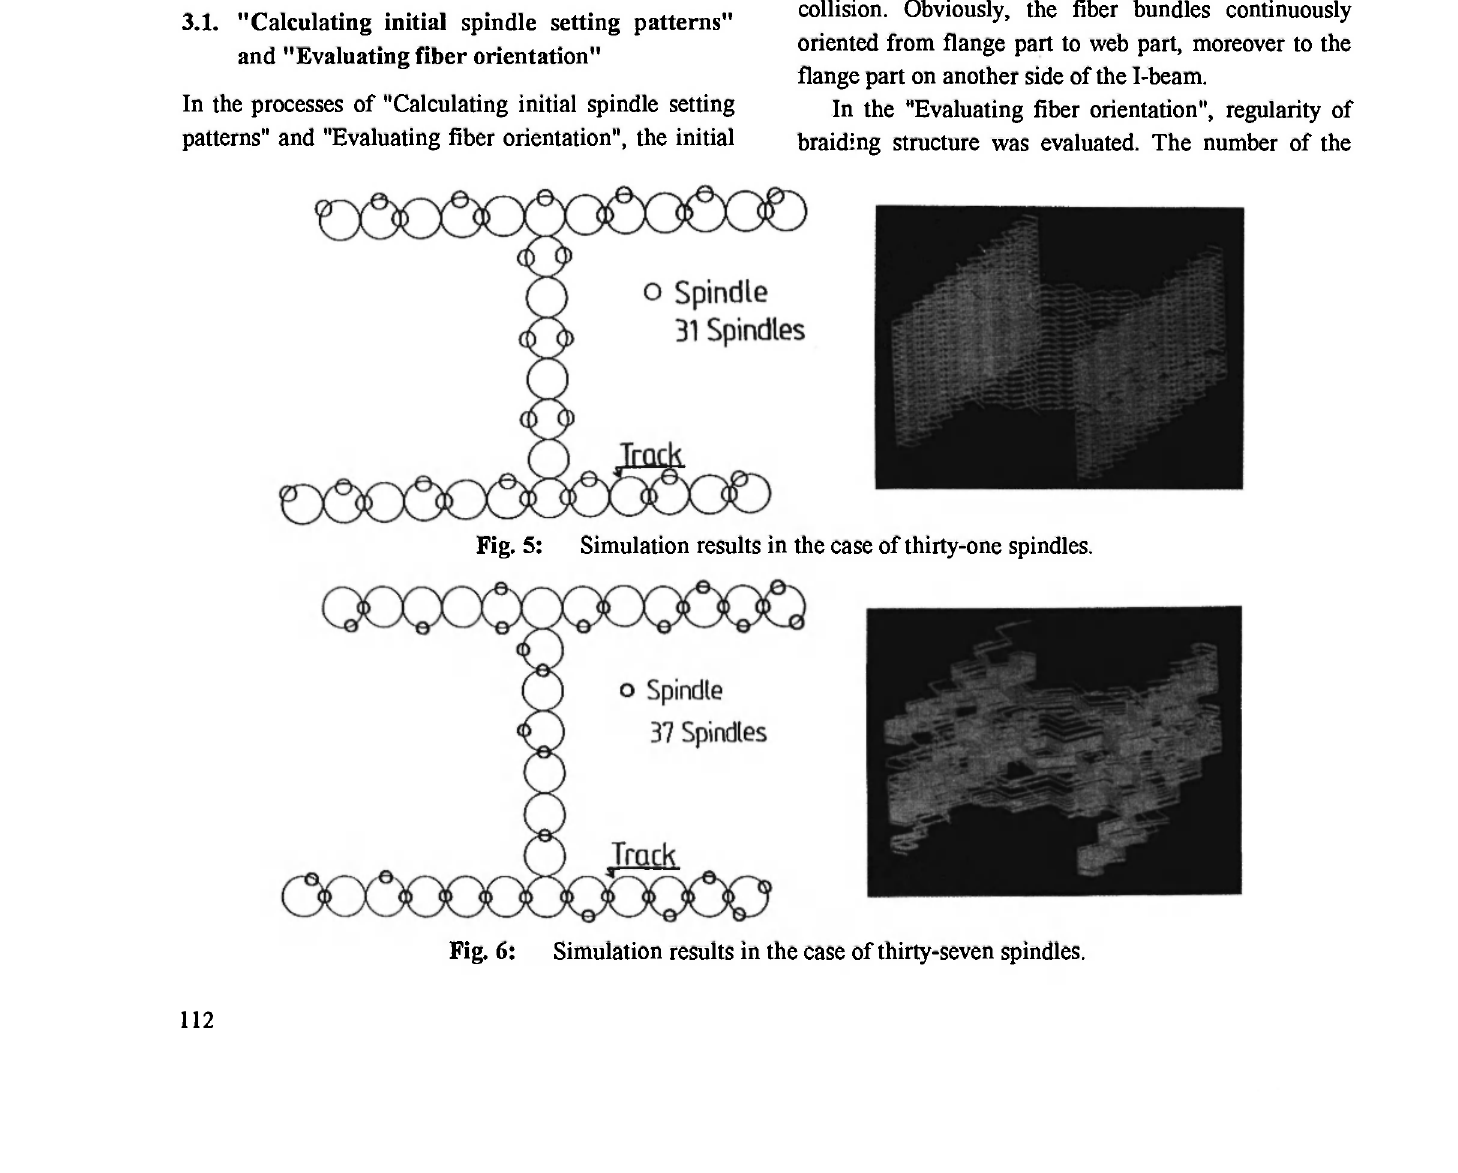
Fig. 5: Simulation results in the case of thirty-one spindles.